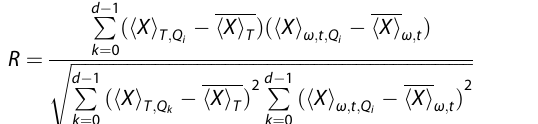
The h P 1 i ω ; are calculated for a T 1 delay time of τ = 50 μ s for 10 t qubits in the device for the fi rst time slice and a cutoff frequency Δ ω /2 π = 5 MHz. A qualitatively close agreement for all 10 qubits is observed, see Fig. 5a. A h T 1 i ω ; can also be estimated for each h P 1 i ω ; t assuming an exponential decay. The approximate equivalence of h T i h T i is seen in the scatter plot of Fig. 5a inset. A near ω ; t and 1 1 T 1:1 relationship is observed when this approach is applied more broadly across many IBM devices, see supplemental information S3. Furthermore, the poorer correlation between h T 1 i single instance of T 1 measurements, is also shown by larger scatter, as seen in Fig. 5a inset. To quantify with a single value the correlation between h T 1 i h P i and their estimators for many qubits, we use a Pearson R 1 T measure across the ten odd-labeled qubits,